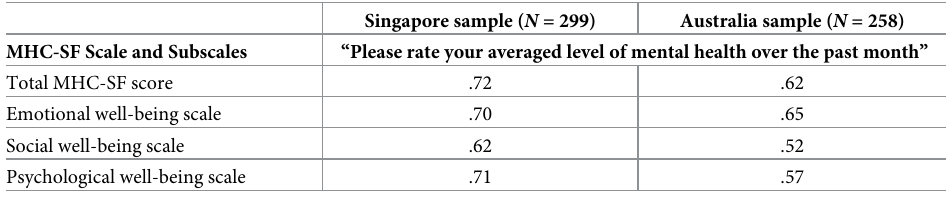
Table 9. Pearson’s correlations of MHC-SF and self-rated question on mental